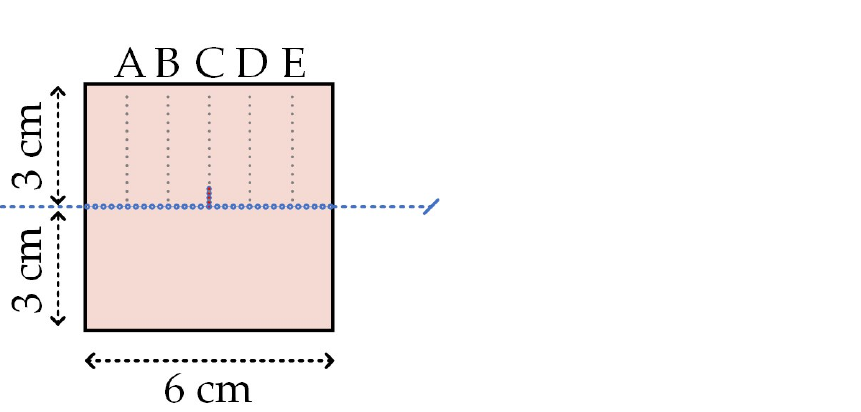
Figure 4. The schematic representation of the fiber on the silicone layer. The fiber line is divided in 5 points of investigation, spaced 1 cm between each other, tagged as A, B, C, D, E.